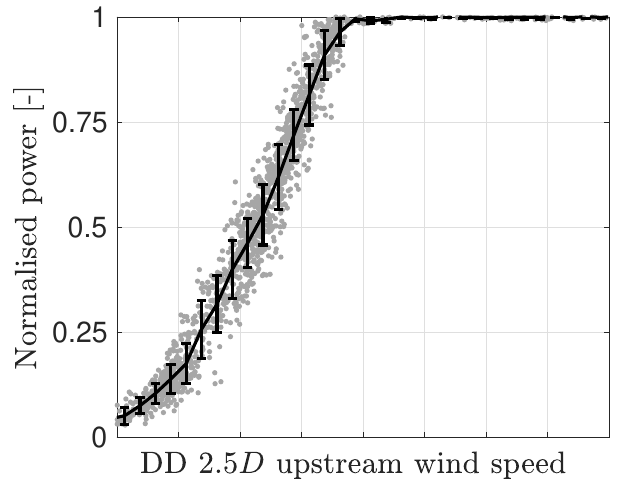
Figure 9. Normalised wind turbine power curve based on 1656 samples of dual-Doppler wind speeds 2.5 D upstream of the rotor, at 100m height (first row of wind turbines). The line is the binned mean power. The error bars represent the standard deviation in 0.5 m/s wind speed